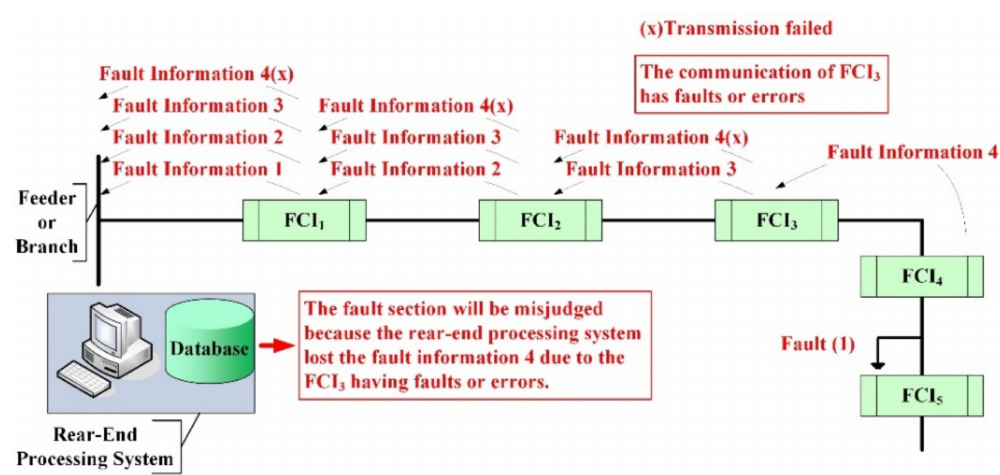
Figure 8. Fault information forwarded correctly.